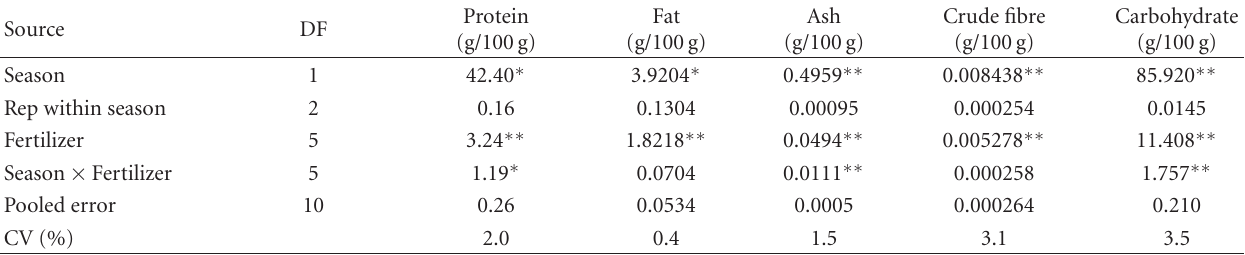
Table 1: Combined analysis of variance showing means squares for protein, fat, ash, crude fibre, and carbohydrate contents of Pumpkin seed as influenced by Season and NPK fertilizer.